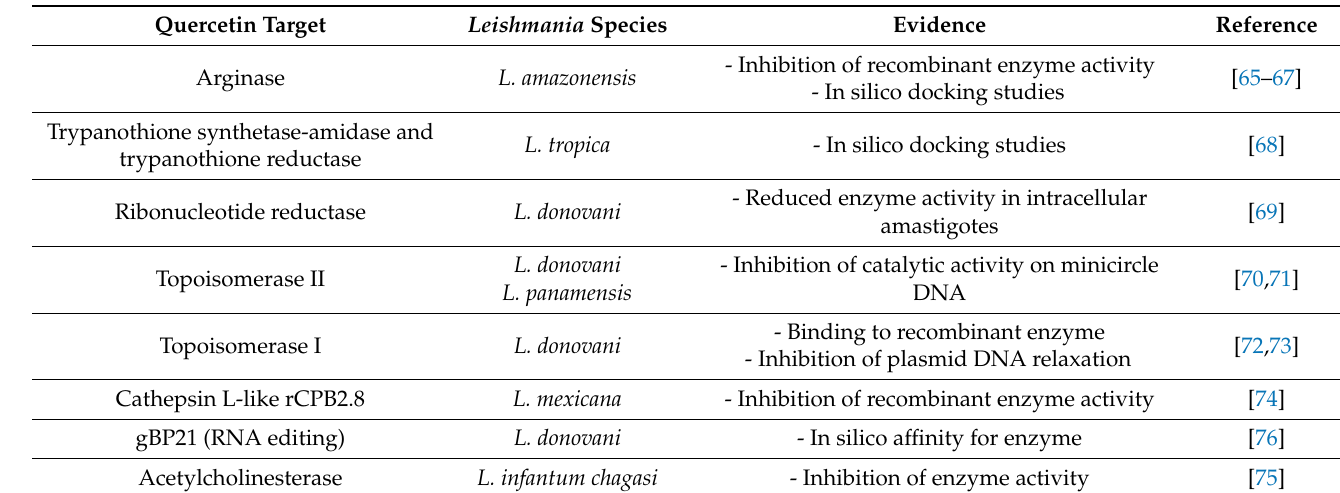
Table 2. Cellular targets of